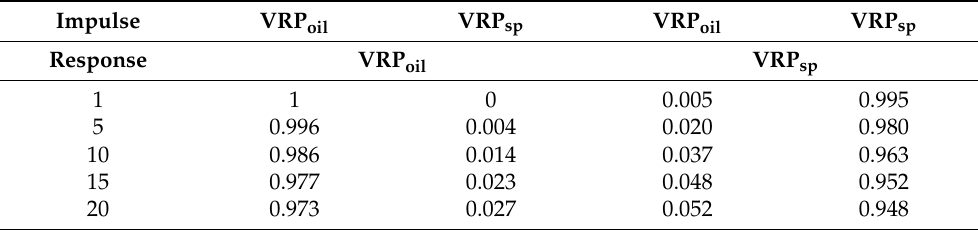
Table 6. Variance decompositions (whole period).